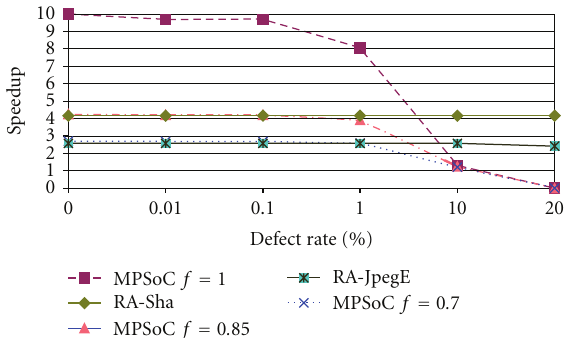
Figure 18: Graceful degradation of sha and jpegE applications— comparison performed considering applications with di ff erent degrees of parallelism running on the 10-core MPSoC without fault tolerance approach.